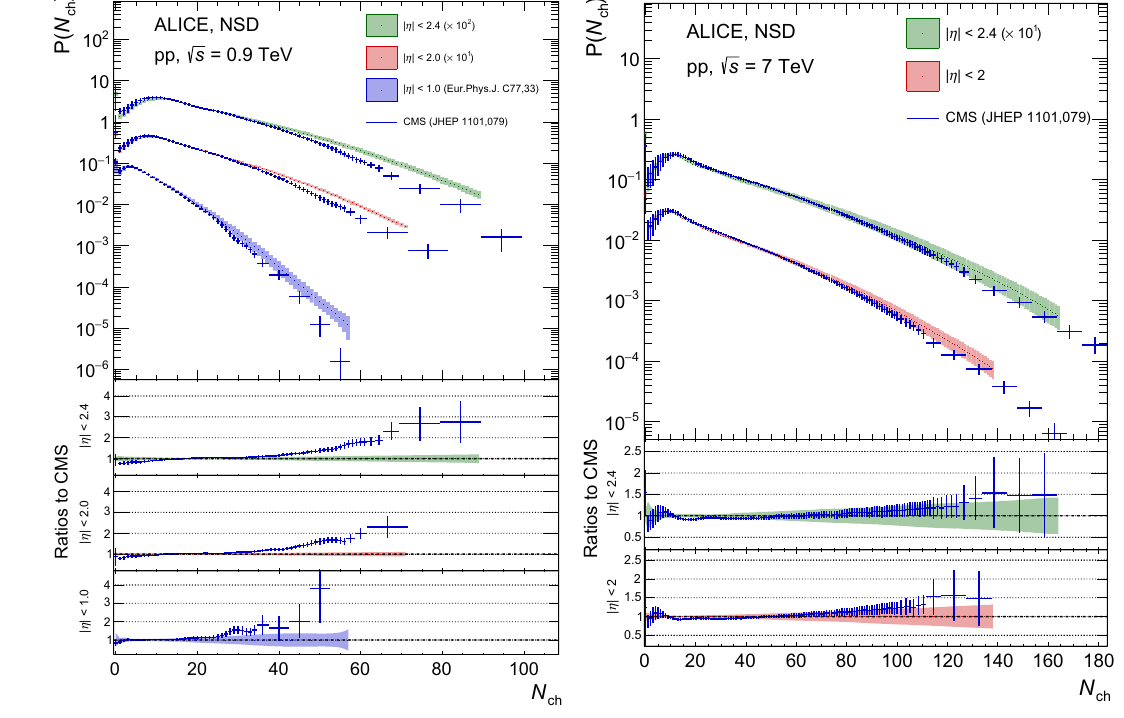
√ s = 0 . 9 TeV (left) and 7 TeV (right) with CMS [5] measurements